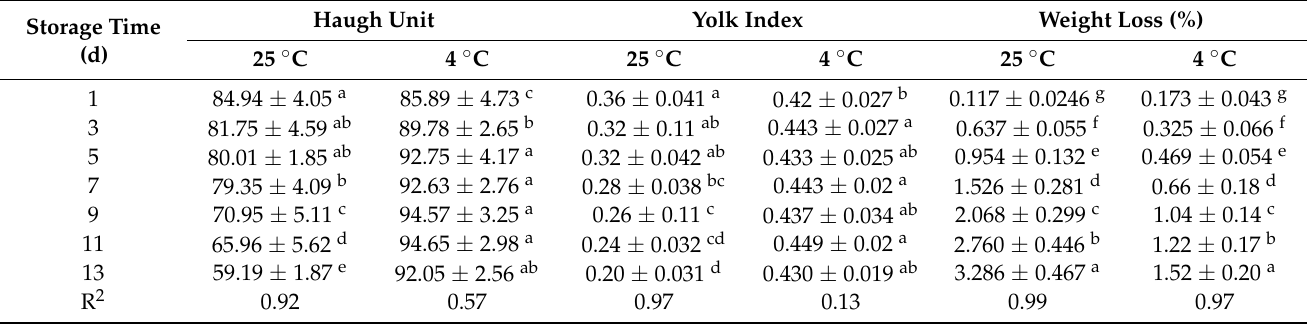
Table 1. Physical indexes of eggs freshness stored at temperature of 4 ◦ C and 25 ◦